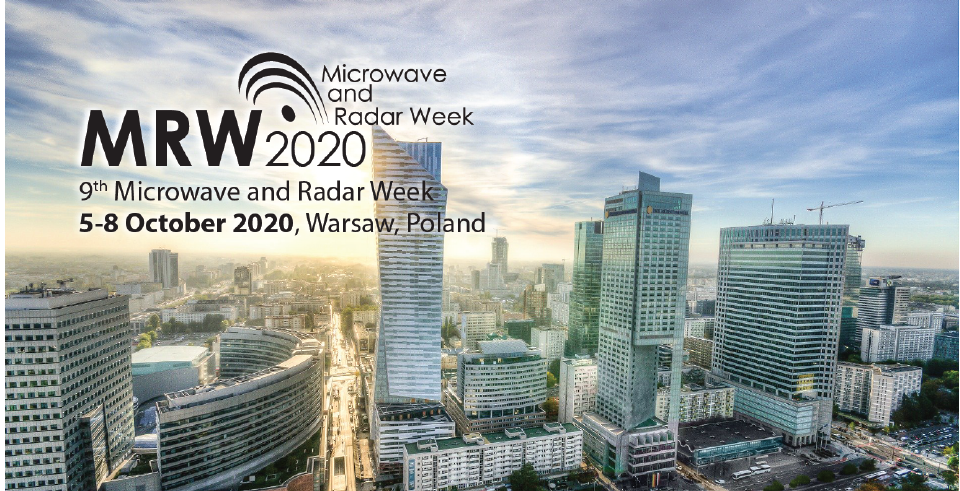
Figure 1. A photo of Warsaw city (MRW 2020 venue) center, from MRW 2020 Call for Papers